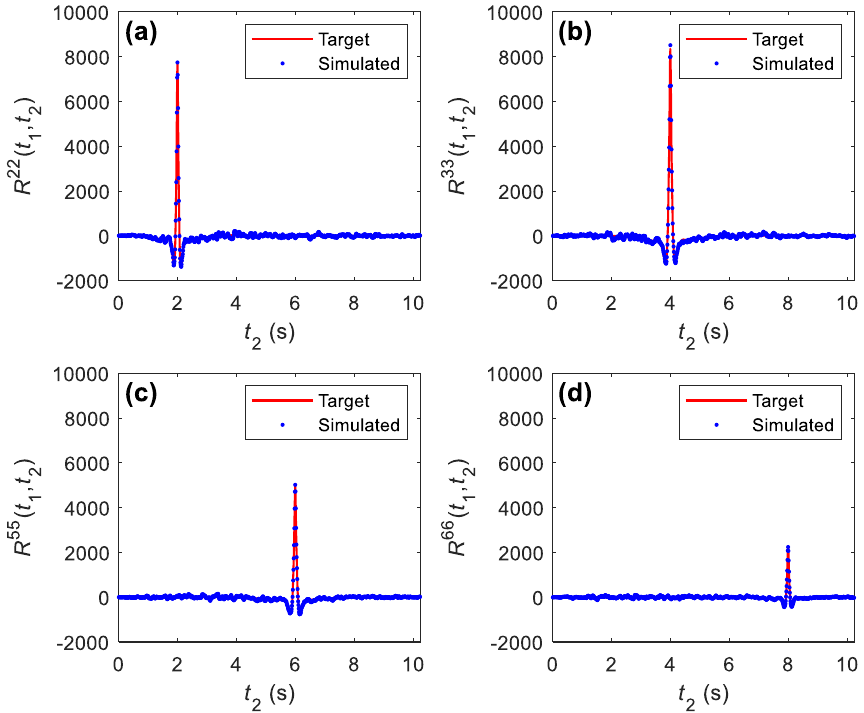
Fig. 3 Comparison of auto-correlation functions in the numerical example: a R 22 ( t 1 , t 2 ) at t 1 at t 1 4 s, c R 55 ( t 1 , t 2 ) at t 1 =